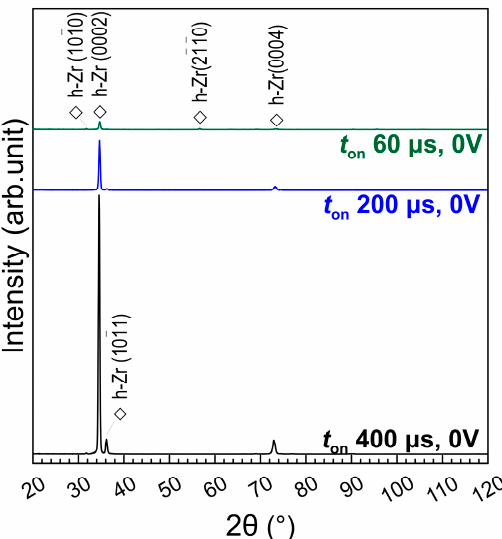
Figure 4. X-ray diffractograms of Zr films deposited at the argon pressure of 1.2 Pa and the substrate bias of 0 V with different HiPIMS pulse widths ( t on ).